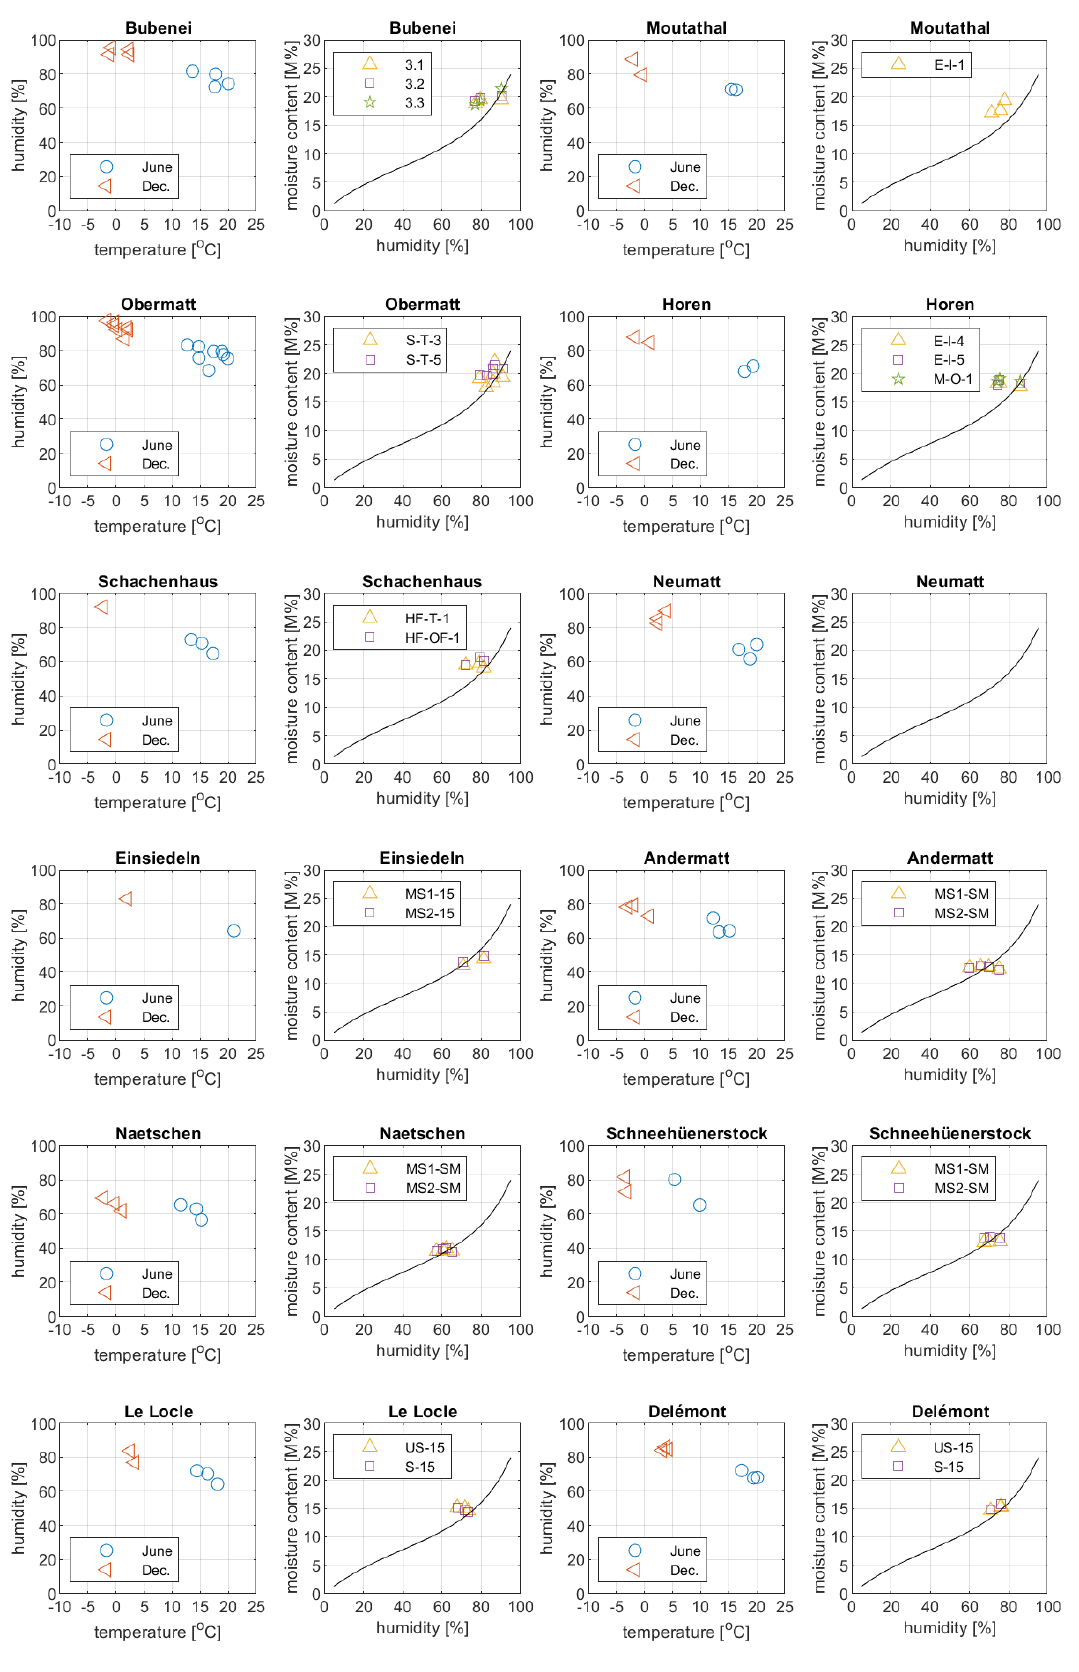
Figure 10. Comparison of the measured temperature and relative humidity in June and December and the annual average measured relative humidity and moisture content in the reference loca- tions.